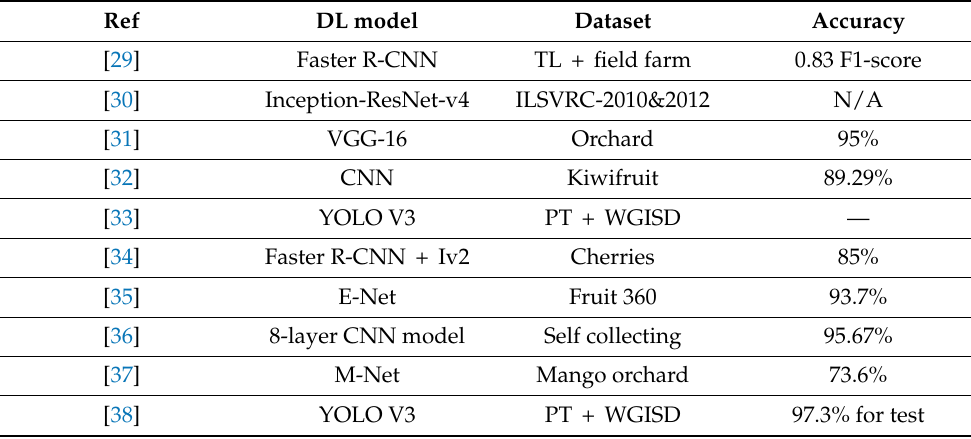
Table 1. Summary of different DL methods for counting fruit.